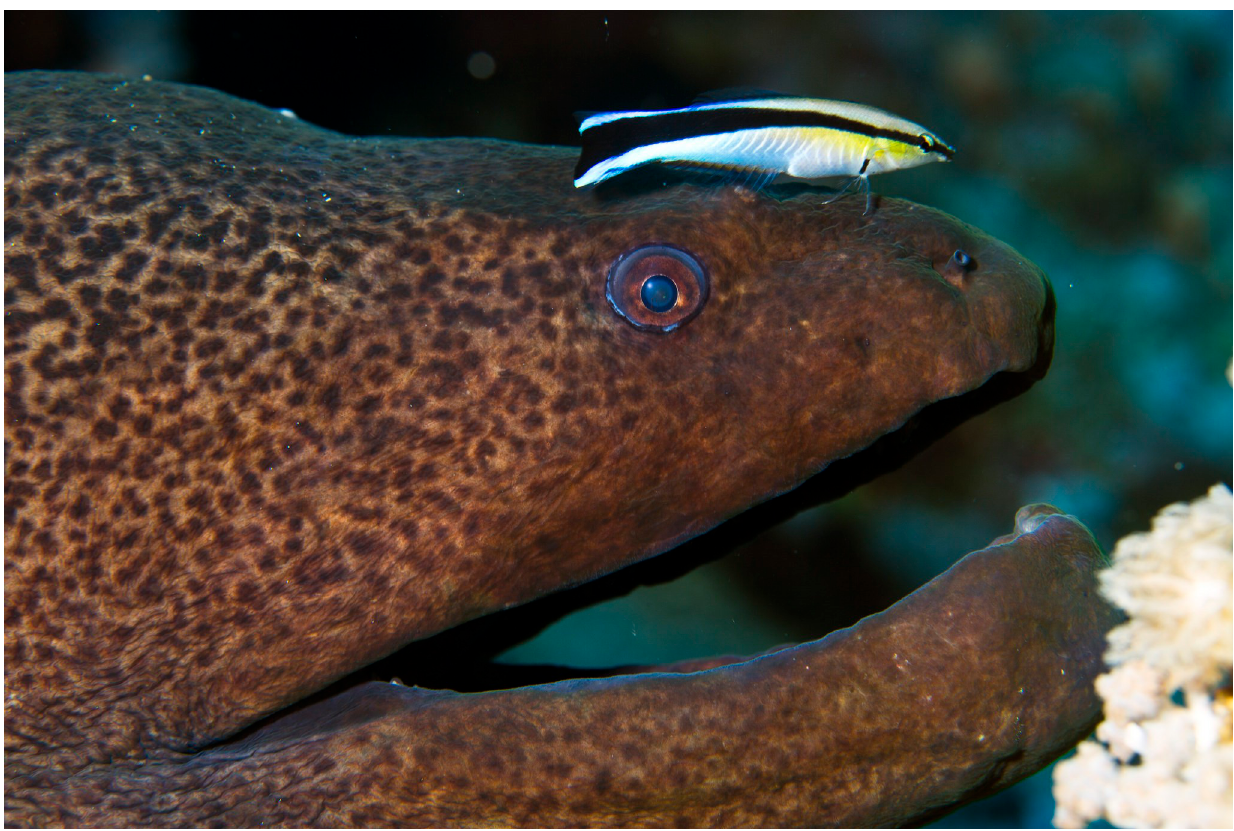
Fig 2. A cleaner wrasse, Labroides dimidiatus , attends to a giant moray eel, Gymnothorax javanicus . Image credit: Silke Baron (Flickr).